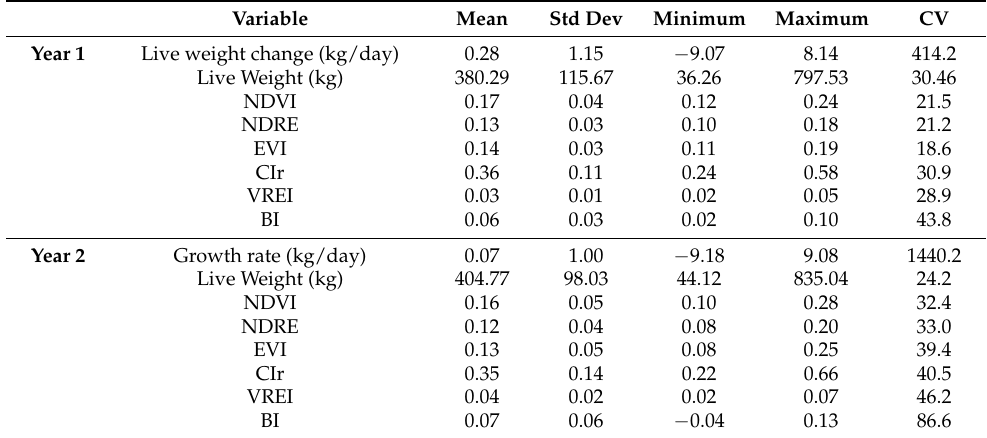
Table 3. Summary statistics for beef cattle performance and vegetation indices from Sentinel-2 satellite imagery measured across the two-year